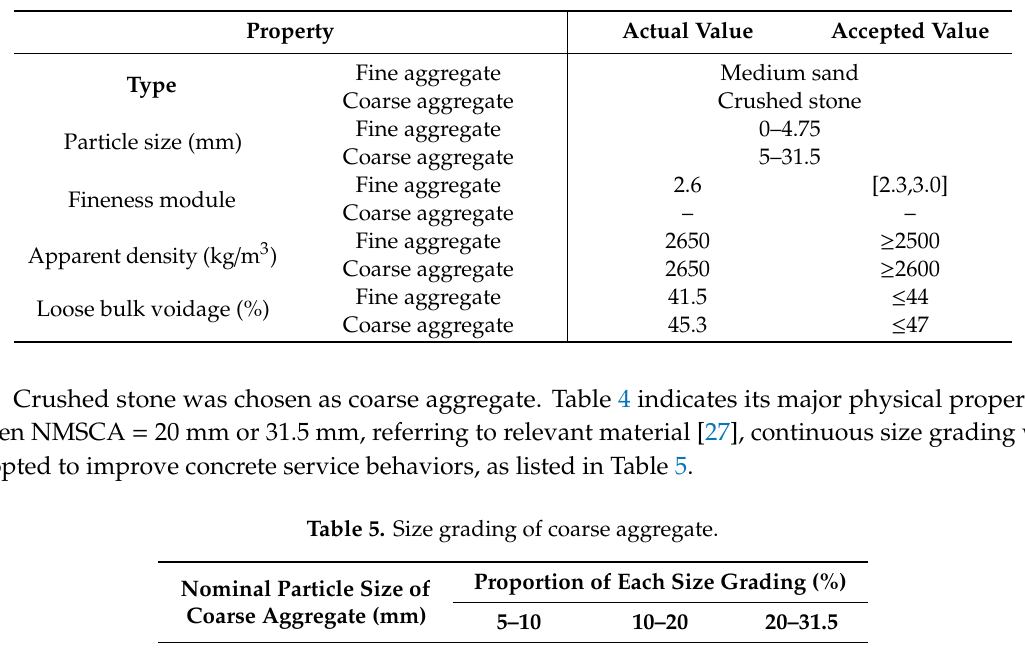
Table 4. Physical properties of aggregates.